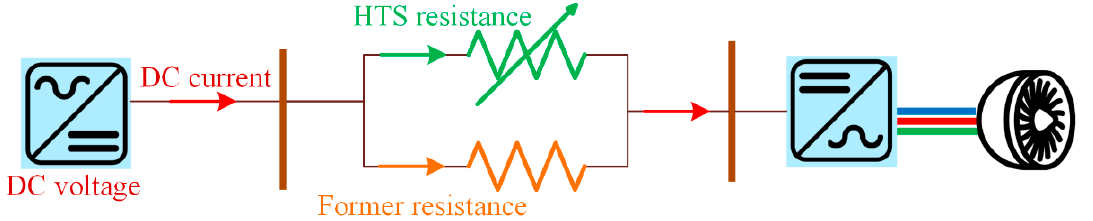
Figure 2 . The equivalent circuit model of a DC HTS cable used in cryo-aircraft to deliver the required power by the propellers .